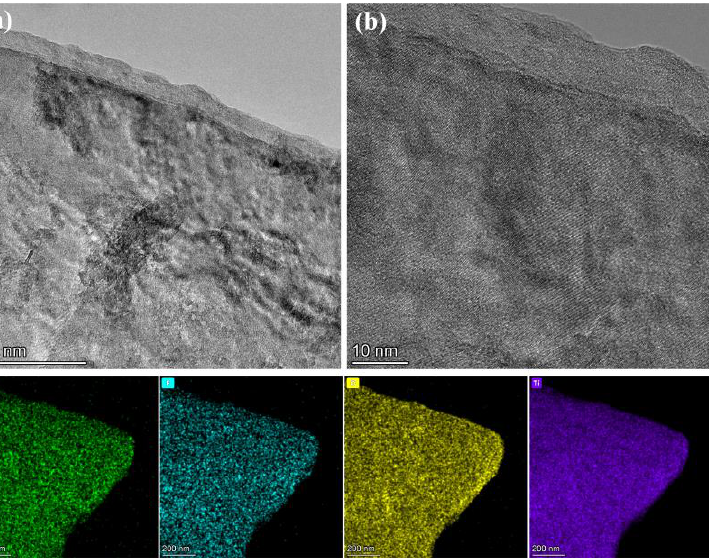
Figure 2. Microstructure characterizations of the Ti 3 C 2 T x -T(O). ( a ) TEM image; ( b ) HRTEM image and the elemental EDS-mapping images of C, F, O, and Ti elements.